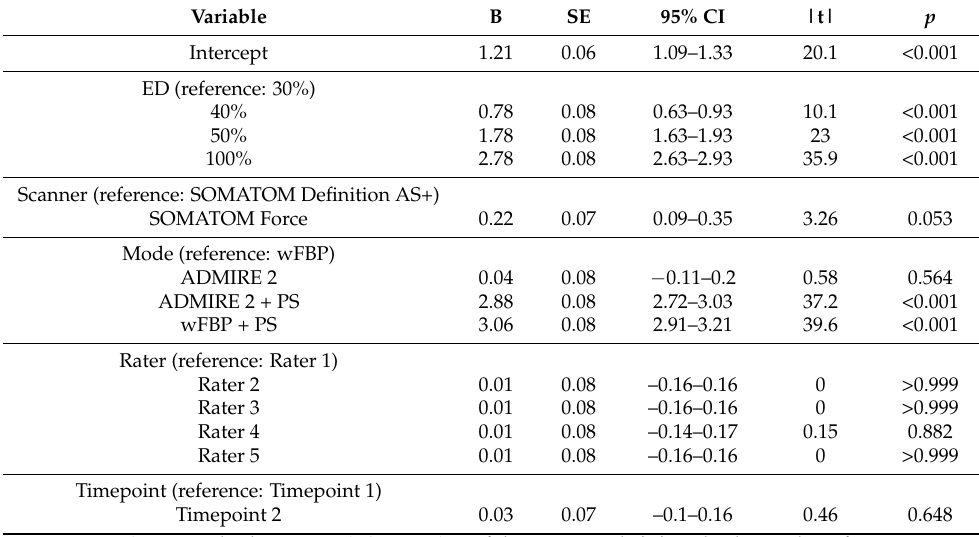
Table 3. Linear regression metrics: subjective image quality.